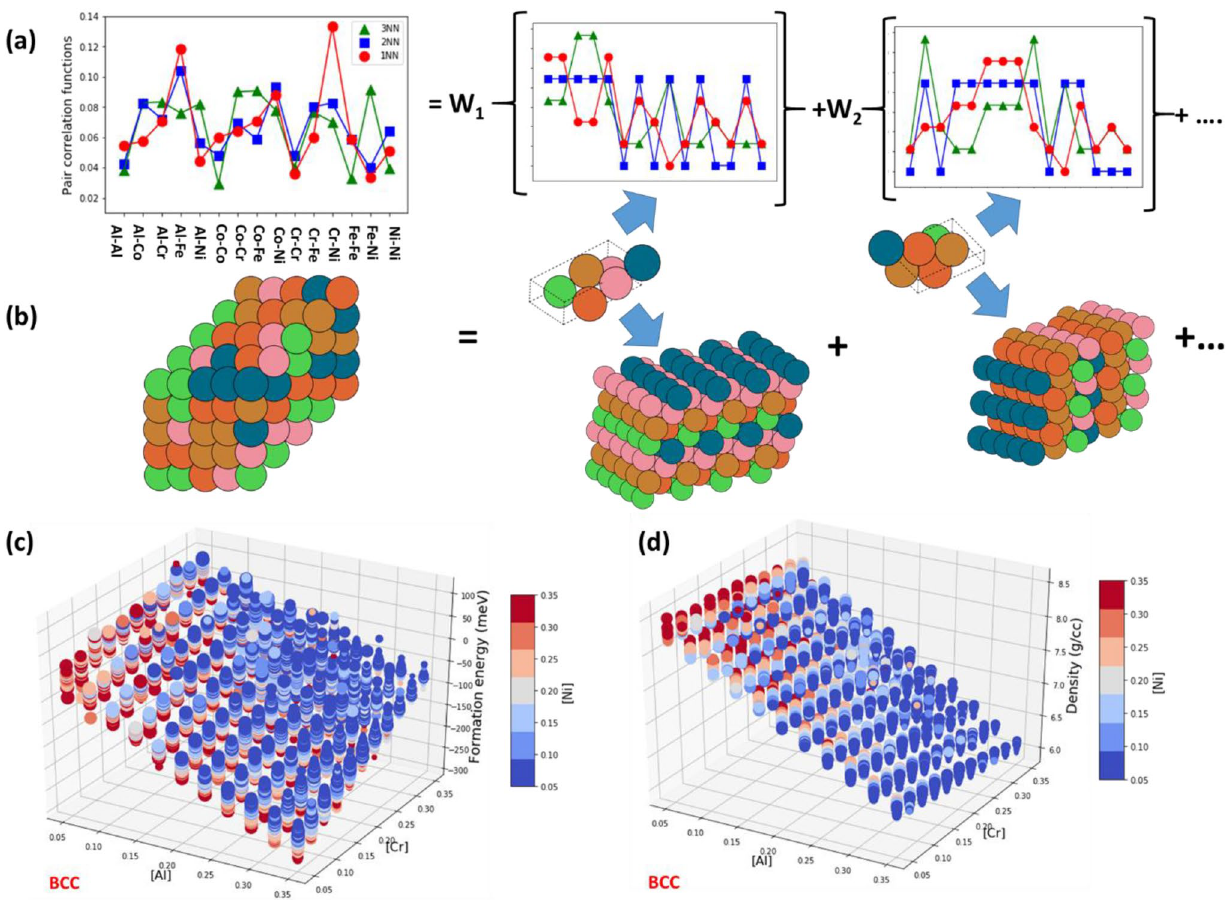
Figure 1. ( a ), ( b ) Schematic representation of the PSSOS method: ( a ) For a given composition of a quinary HEA in the ideal solid solution, one calculates the pair correlation functions, which must be precisely matched with a linear combination of the weighted pair correlation functions of a set of selected SOS. In our calculations, the pair correlation functions are matched up to 3rd nearest neighbor range with that of the ideal solid solution. The target SQS HEA sample and two 6-atom SOS samples taken from the preselected SOS set with their pair correlation functions are illustrated in ( b ). For each SOS 6-atom sample, its supercell version, obtained by its replication along the three directions, is presented to illustrate its ordered structure. ( c ), ( d ) The formation energy per atom ( c ) and mass density ( d ) of AlCoCrFeNi HEAs in BCC lattice structure as a function of the molar fraction of Al and Cr. Marker color indicates the molar fraction of Ni, while marker size corresponds to the molar fraction of Co for a given HEA Marker color indicates that an increase in the molar fraction of Ni also lowers the formation energy (see Fig. 3b, and the green curve with triangles in Fig. 3f). Yet, the effect of Ni is significantly weaker than that of Al: the mean slope for Ni in Fig. 3f is smaller than that of Al. An increase in the molar fraction of Cr, in contrast to Al and Ni, raises the formation energy of AlCoCrFeNi HEA (see Fig. 3c, and the blue curve with squares in Fig. 3f). The effect of Fe is like that of Cr (see Fig. 3d, and the black curve with cross marks in Fig. 3f), but it is comparatively weaker. The effect of Co on the formation energy is shown in Fig. 3e. Contrary to other principal elements, the optimal value of the molar fraction of Co that leads to the lowest formation energy is located within a narrow range between 17 and 22% of Co (see the orange curve with diamonds in Fig. 3f). Similar results were obtained for the effect of molar fraction of the prin- cipal elements on the formation energy of the AlCoCrFeNi HEA with a BCC lattice (see Supplementary Fig. S2). Mass density. The density of the AlCoCrFeNi HEA with a BCC lattice is plotted vs the molar fraction of Al and Cr in a three-dimensional plot as shown in Fig. 2d (see also Supplementary Fig. S1 for FCC lattice), where the molar fraction of Ni is indicated by marker color, and the molar fraction of Co by marker size. The density manifold is represented by an inclined plane for both the FCC and BCC lattices. Figure 4 plots the density of AlCoCrFeNi HEA with BCC lattice against a molar fraction of the constituent elements (see also Supplementary Fig. S3 for FCC lattice). The density of the HEA compositions with the same molar fraction of a specific element is plotted as a stacked column. Marker color and size indicate the molar fraction of two other principal elements. The density minimum (bottom of each stacked column) as a function of the molar fraction of the principal element is plotted in Fig. 4f.